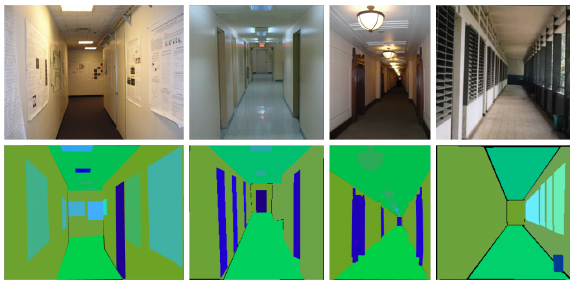
Figure 1. Typical structural scene – the long corridor. The ceiling and the floor are usually texture-less, and the floor is rarely stacked with objects due to its function. Repeated textures of the doors and posters are confusing to visual